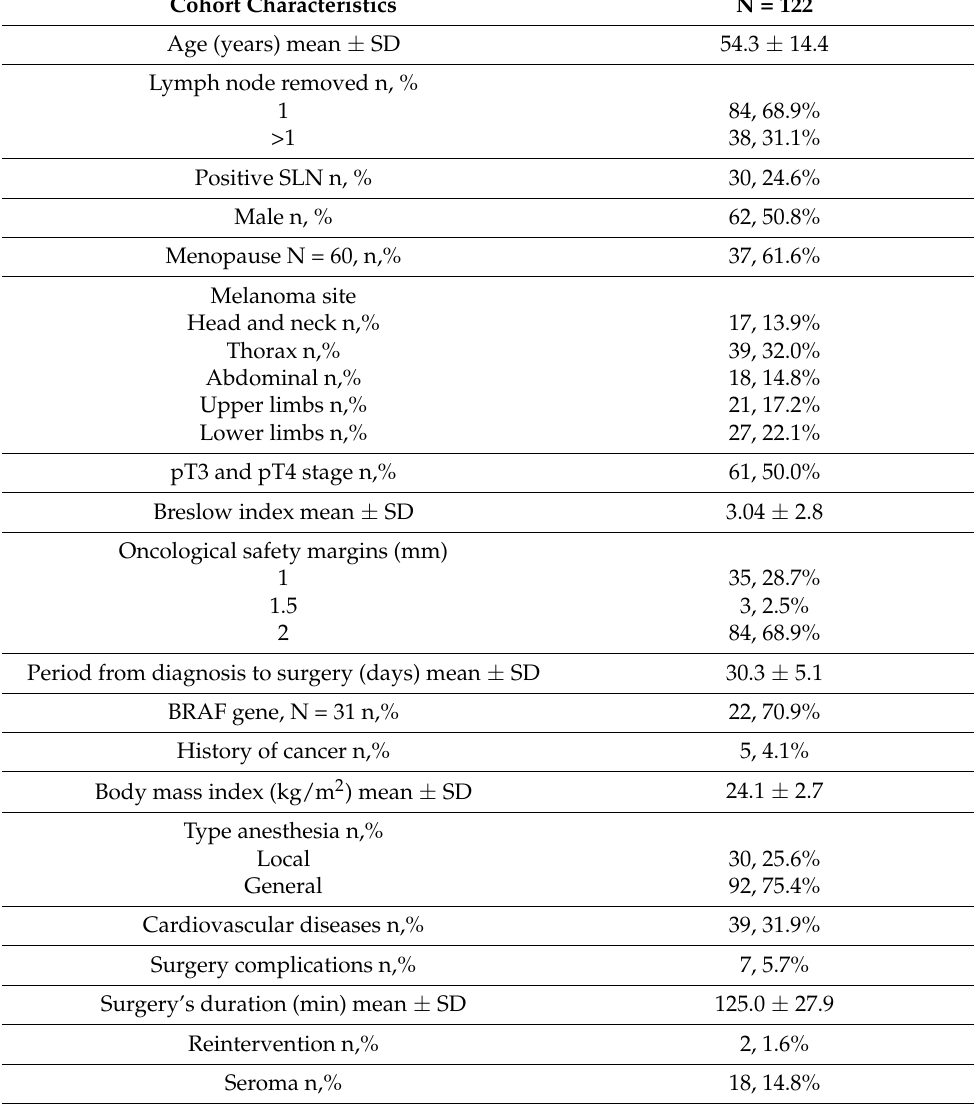
Table 1. General and surgical characteristics of